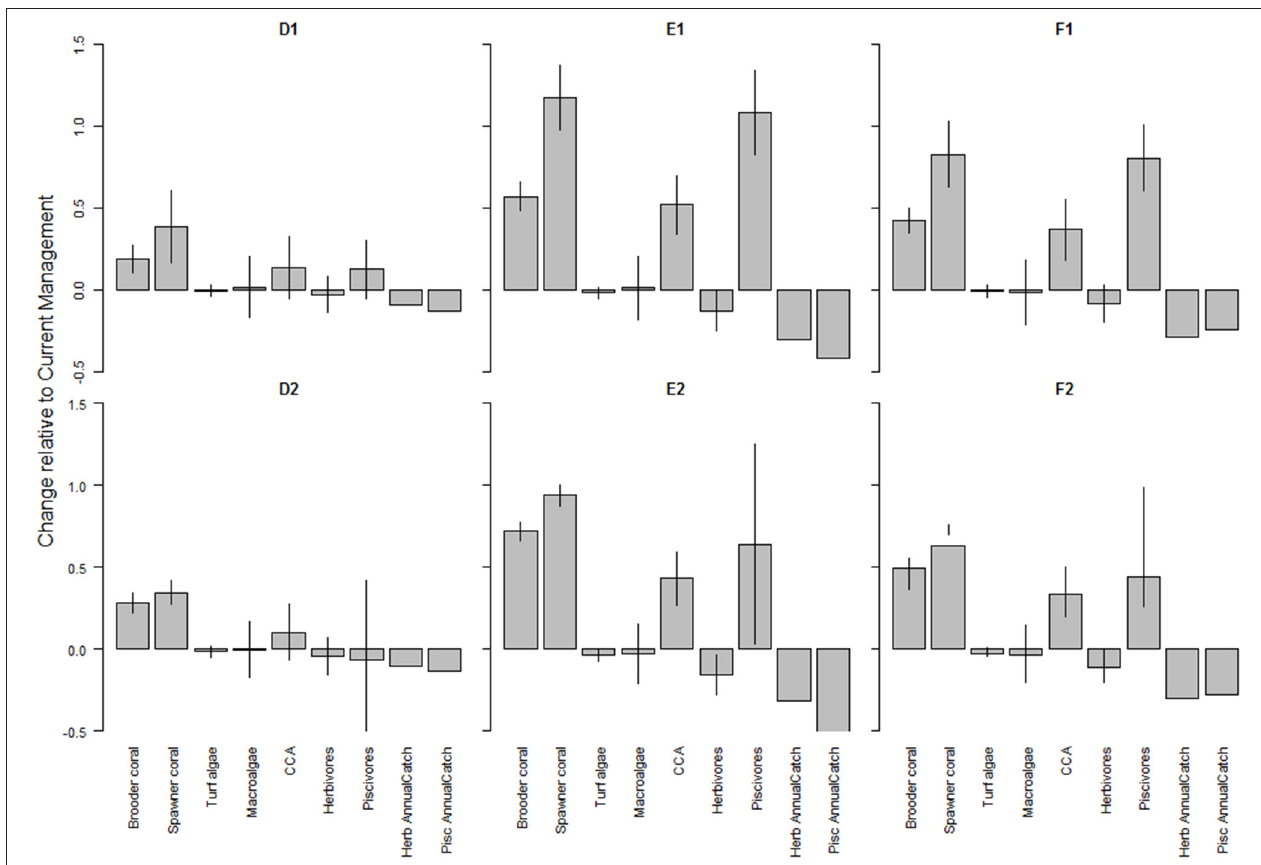
FIGURE 5 | Changes in benthic cover (corals and algae) and fish (herbivores and piscivores) biomass as a result of local management under ( top row ) severe climate-related stressors and ( bottom row ) less severe climate-related stressors. A value of 0 indicates no change from the outcome in 2050 under Current Management, values > 0 indicate an improvement (or, more accurately, less of a decline from the Current Management), while values < 0 indicate a worsening of the decline relative to Current Management. The bars represent ± 1 standard error as a percentage of the mean. The local management scenarios include: (D) 10% no-take MPAs and low sediment mitigation, (E) 30% MPAs and strict sediment mitigation, and (F) 30% MPAs with an additional 20% reduced piscivore fishing effort and strict sediment mitigation. CCA is crustose coralline